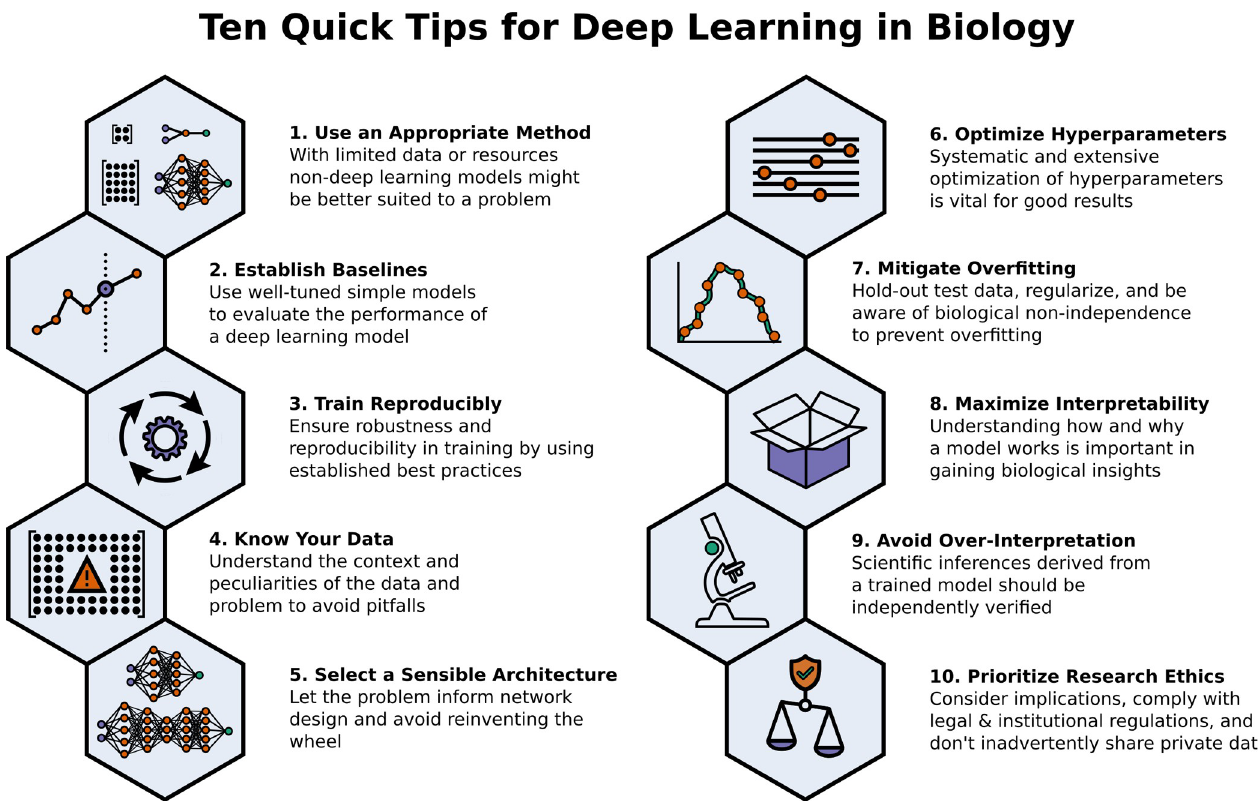
Fig 1. A summary overview of the 10 tips for using deep learning in biological research.